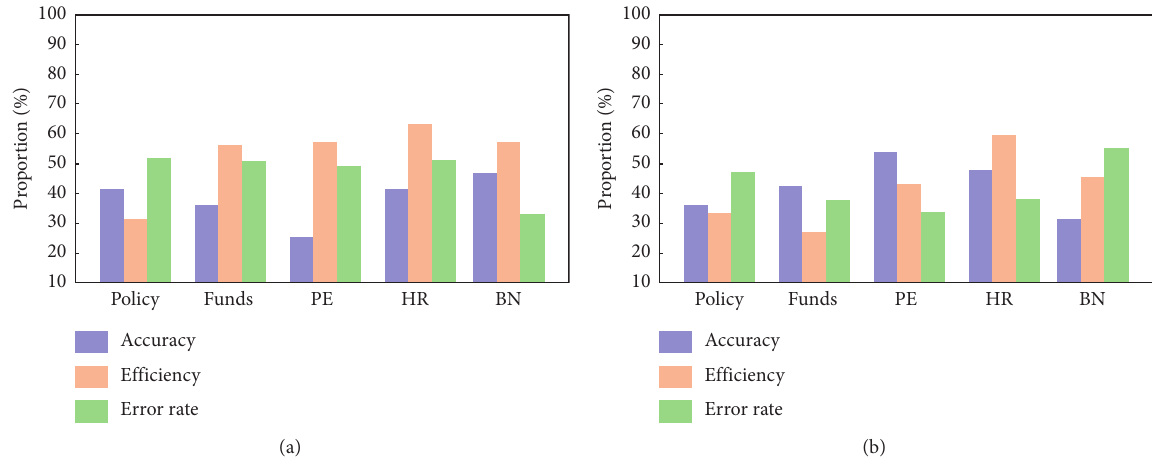
Figure 7: Proportions of five main risk factors in assessing college student entrepreneurship with (a) support vector machine and (b) hierarchical